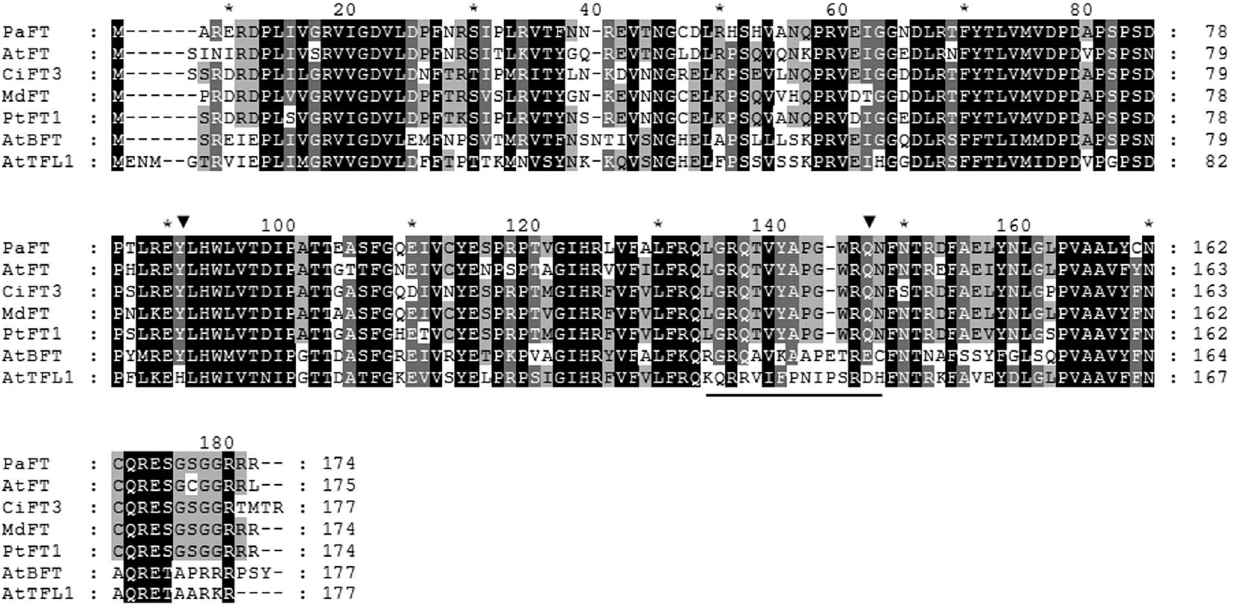
Figure 5. Amino acid sequence comparison and structural features of avocado PaFT. Comparison of the deduced amino acid sequence of PaFT (ac: AIG92770) with four representative FT proteins, including: Arabidopsis AtFT (ac: BAA77838.1), citrus ( Citrus unshiu ) CiFT3 (ac: BAA77836.1), apple ( Malus x domestica ) MdFT (ac: ACL98164.1) and populus ( Populus tremula ) PtFT1(ac: ABD52003.1), together with BFT and TFL1 proteins from Arabidopsis , AtBFT (ac: Q9FIT4.1) and AtTFL1 (ac: AED90661.1). Residues on black, dark gray and light gray backgrounds indicate 100%, 75%, and 50% amino acid similarity, respectively. Dashed lines indicate gaps introduced to achieve maximum alignment. Key FT residues are marked with triangles. PaFT Tyr-84 and Gln-139 correspond to AtFT Tyr-85 and Gln-140. The conserved amino acid sequence LGRQTVYAPGWRQN, which distinguish FT from TFL and/or BFT, is underlined.